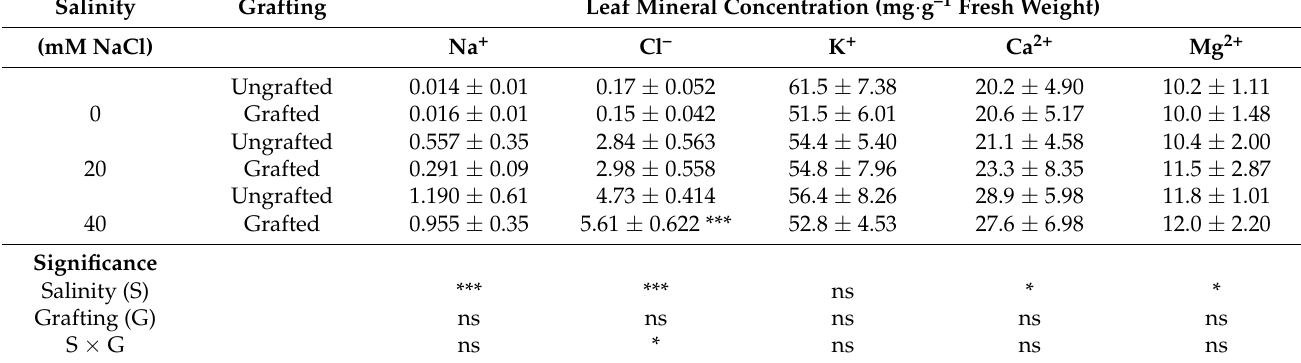
Table 5. Effects of salt stress on leaf mineral concentrations measured in September for ungrafted and grafted bell pepper plants, and their salinity and grafting interactions.